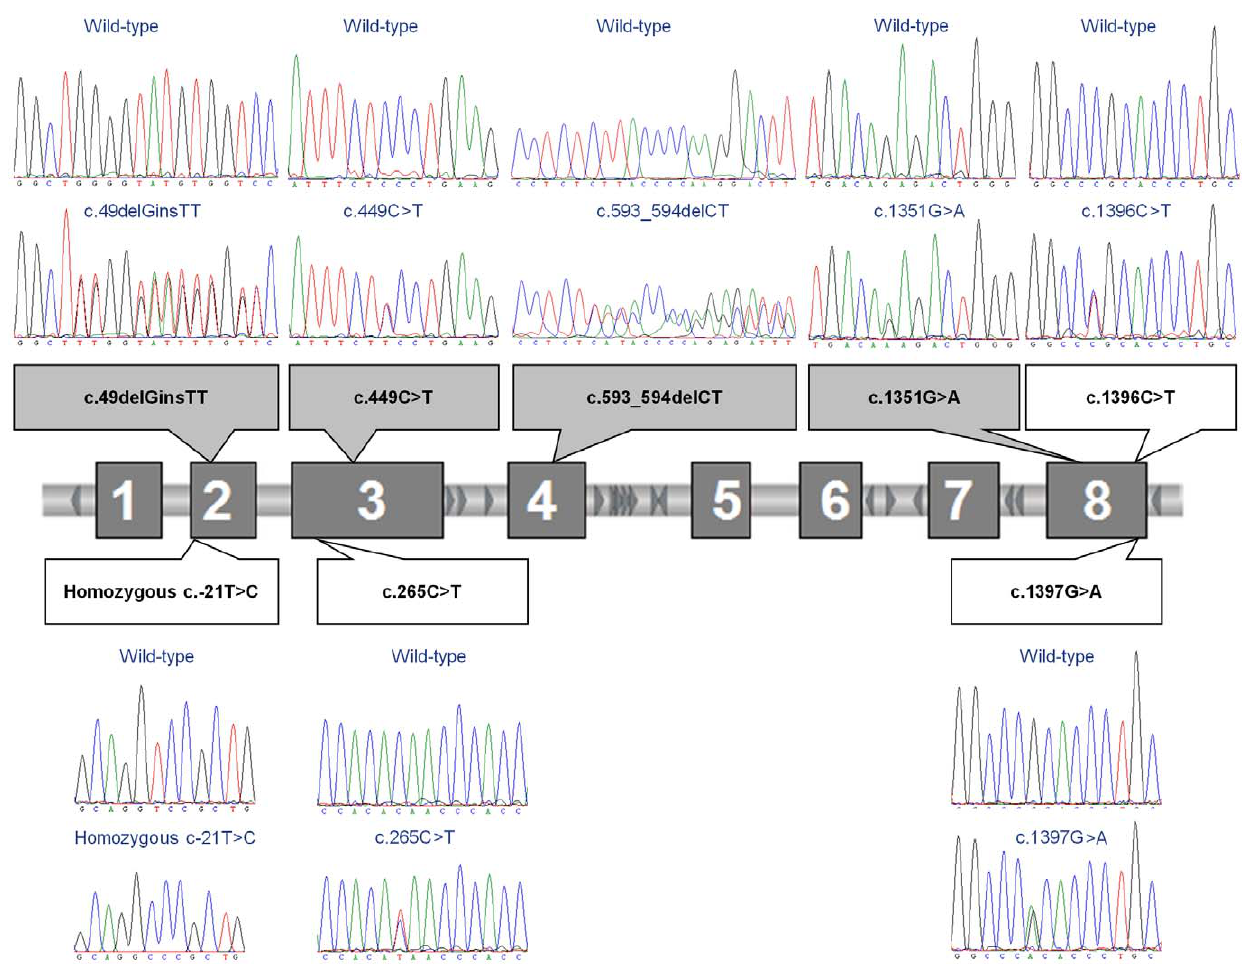
Figure 1. Schematic representation of SERPING1 gene and the mutations identified in Slovenian families with hereditary angioedema. Boxes showing novel mutations identified are shadowed in grey.